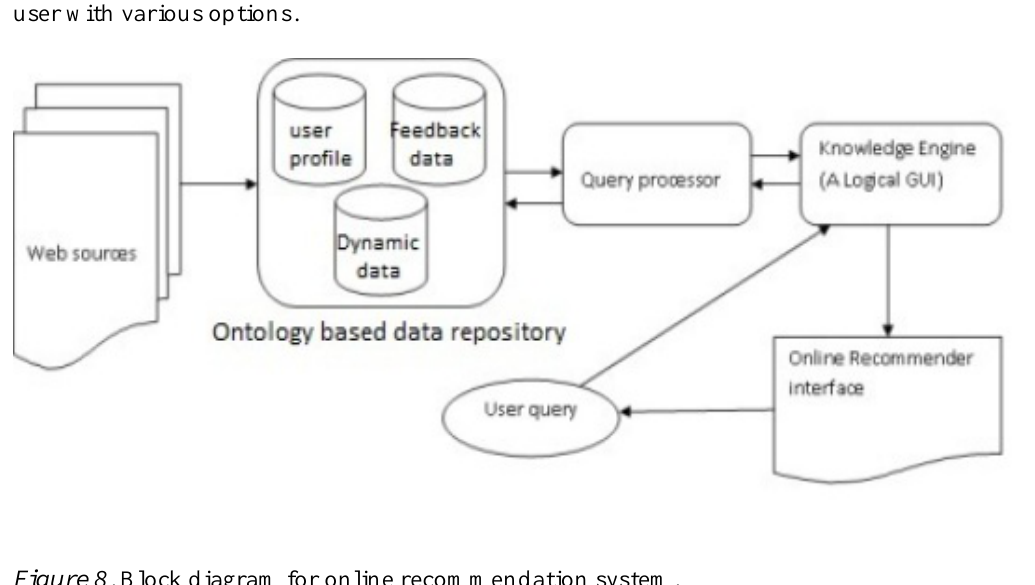
Figure 8 . Block diagram for online recommendation